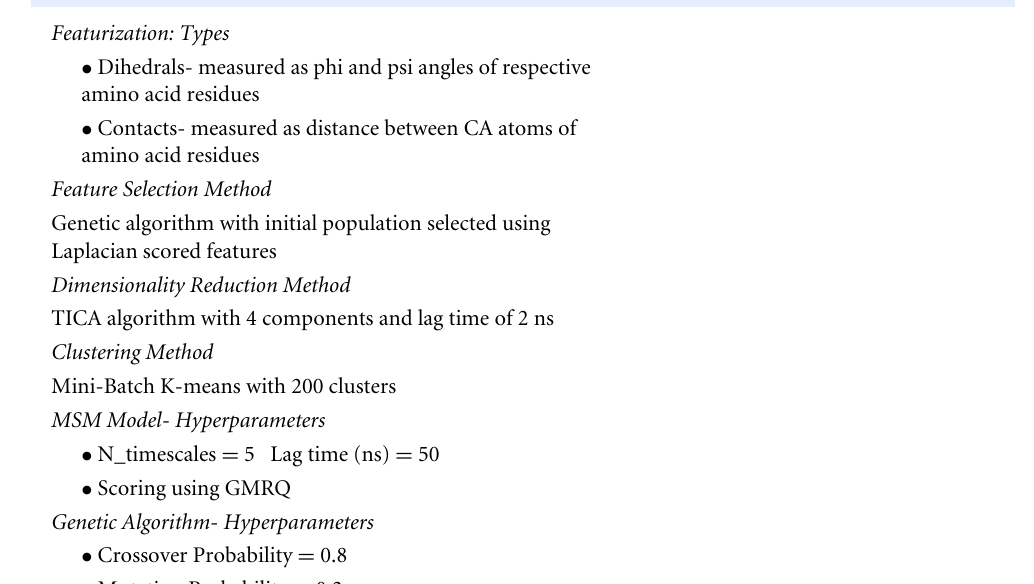
Table 1 Attributes used in each stage of the proposed